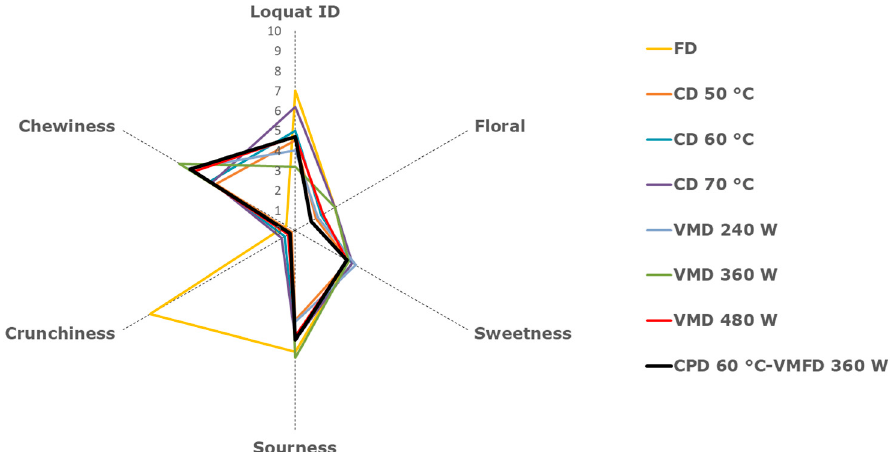
Figure 3. Descriptive sensory analysis of dried loquat. Freeze drying (FD), convective drying (CD) at 50 °C (CD 50), 60 °C (CD 60) and 70 °C (CD 70), vacuum-microwave drying (VMD) at 240 W (VMD 240), 360 W (VMD 360) and 480 W (VMD 480) and combined drying (CPD-VMFD).